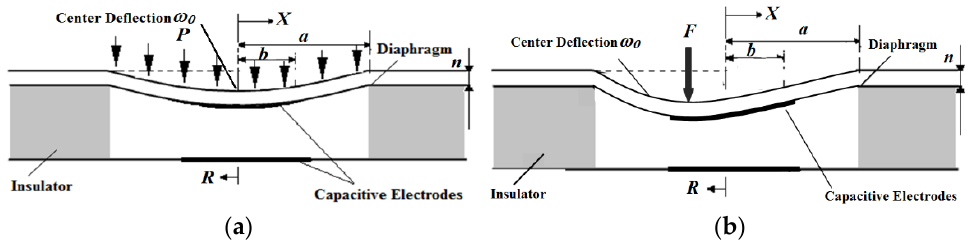
Figure 2. ( a ) Thin circular plate model with uniform load. ( b ) Thin circular plate model with concentrated force.